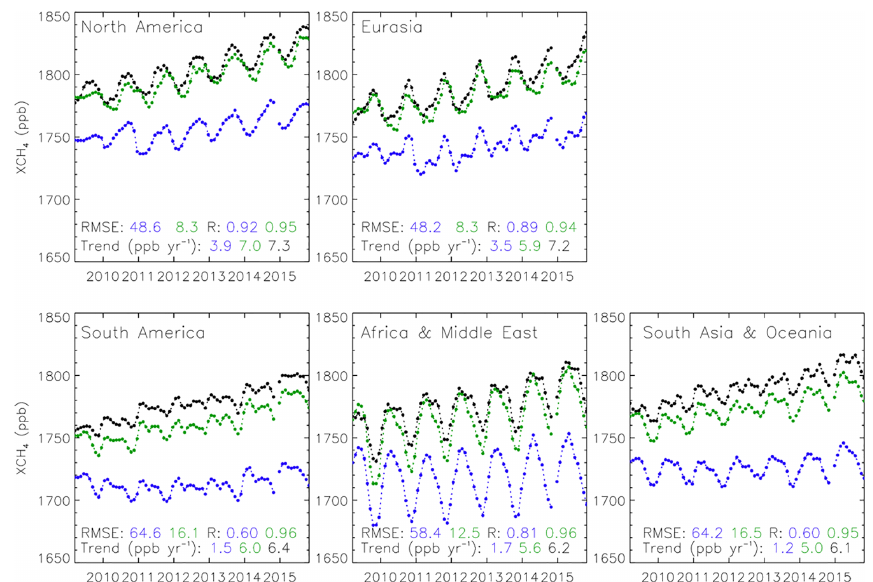
Figure 2. Monthly mean XCH 4 volume mixing ratio (ppb) from GOSAT between April 2009 and December 2015 (black line) for five emissions regions. Also shown are results from TOMCAT simulations with prior (blue) and posterior (green) emissions estimates, both with GOSAT averaging kernels applied. Correlation coefficients, RMSE, and growth rates of the model simulations and GOSAT in each region are shown in the